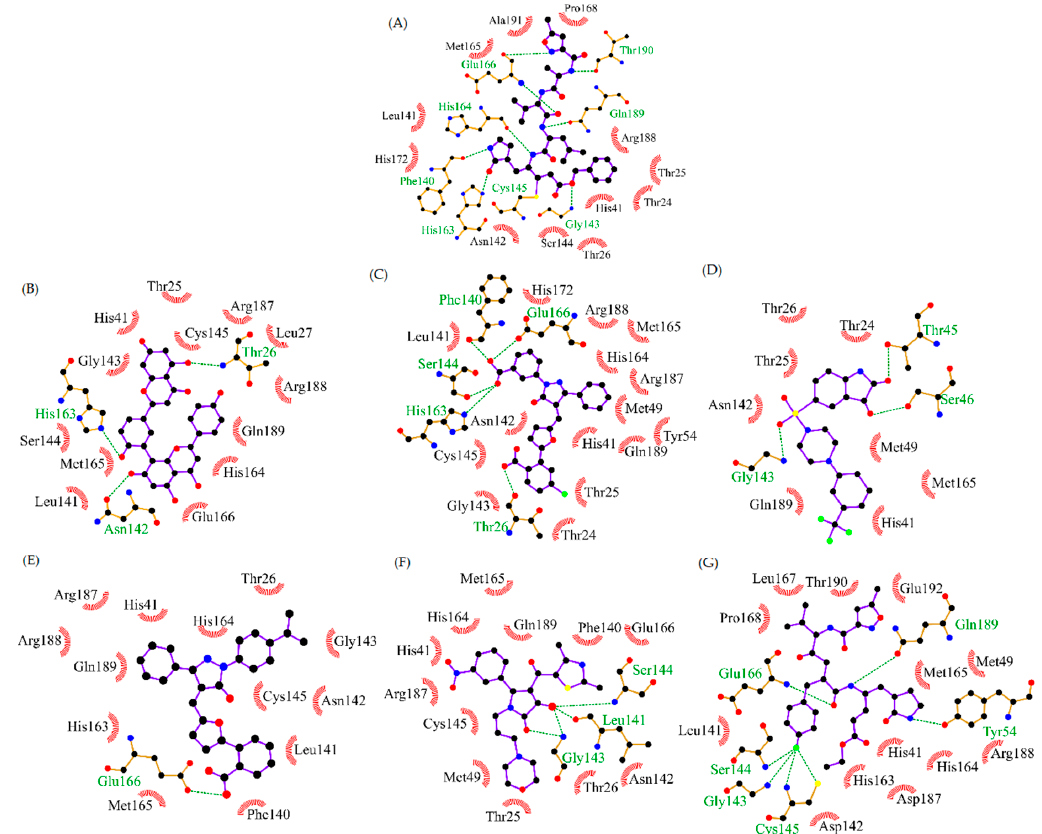
Figure 2. Potential lead inhibitors of SARS-CoV-2 Mpro obtained by comparison with others similar proteins. ( A ) N3 Structure. ( B ) CHEMBL63354 (D.S.: − 10.2 kcal / mol, IC 50 = 8.3 µ M against 3CL-PRO SARS-CoV). ( C ) CHEMBL3808795 (D.S.: − 9.7 kcal / mol, IC 50 = 44.7 µ M against 3CL-PRO SARS-CoV). ( D ) CHEMBL3099535 (D. S: − 9.3 kcal / mol, IC 50 = 100.0 µ M against 3CL-PRO SARS-CoV). ( E ) 50176857 (D.S.: − 8.9 kcal / mol, IC 50 = 11.7 µ M against 3CL-PRO SARS-CoV). ( F ) 503435553 (D.S.: − 8.2 kcal / mol, IC 50 = 101.0 µ M against 3CL-PRO SARS-CoV. ( G ) 11243 (D.S.: − 8.0 kcal / mol, IC 50 = 100.0 µ M against 3CL-PRO SARS-CoV). D.S.: Docking score. Hydrophobic interactions are shown in red and hydrogen bonds in